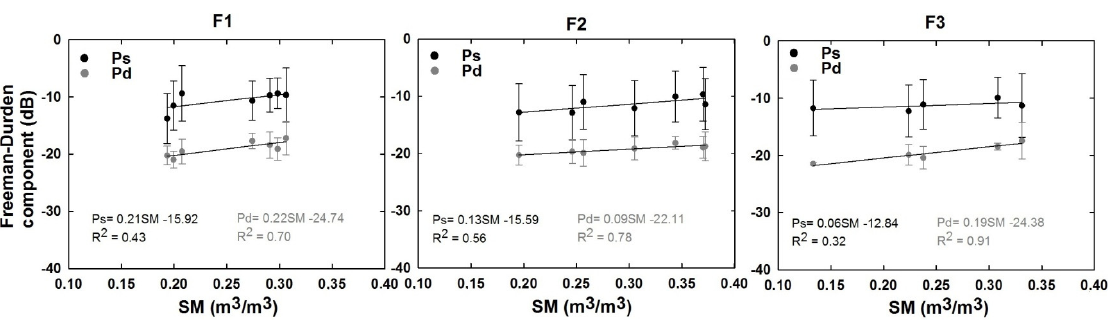
Figure 8. Relationships between the soil moisture and the mean values of Ps and Pd at C-band over F1, F2, and F3 sites. The error bars represent the standard deviation of Ps and Pd within each forest site. Table 9. Correlation coefficients between the soil moisture and the mean values of Ps and Pd at L and C- bands over F1, F2, F3, and F5 sites. Significant correlations ( p -value < 0.05) are denoted with ‘*’.